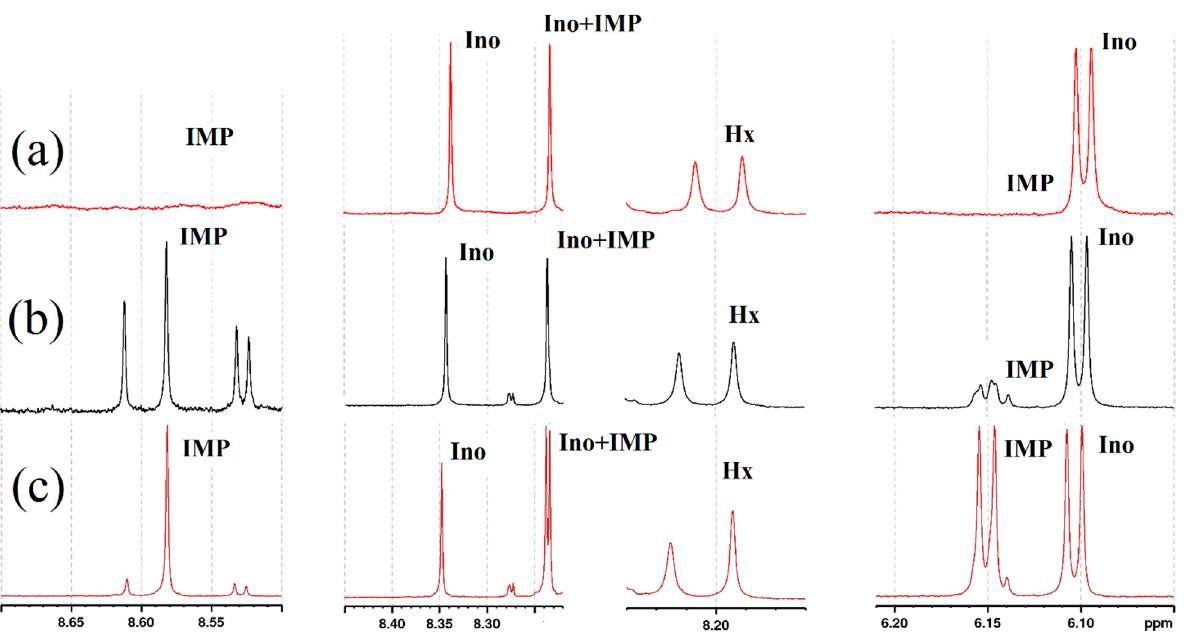
Figure 8. Chromatograms of Alaska Pollock samples before (Raw) and after (Steam) cooking at 100 ° С for 60 min, and difference of the two chromatograms (Steam–Raw).